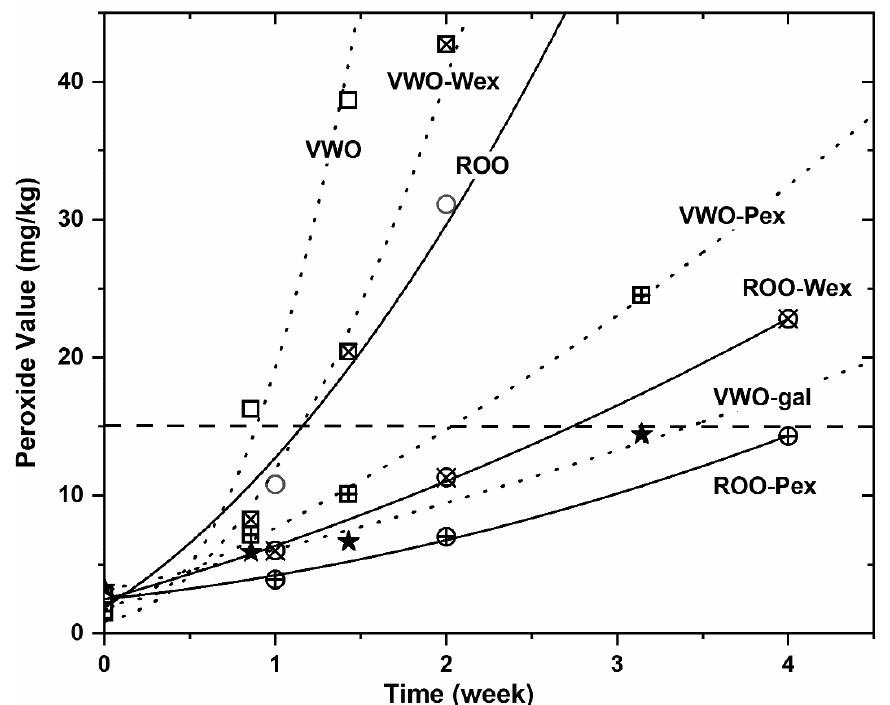
* 40 ◦ C for VWO; 60 ◦ C for VPO and ROO. VWO, virgin walnut oil; VPO, virgin pistachio oil; ROO, refined olive oil. Wex, walnut phenolic extract; Pex, pistachio phenolic extract. OSI, Rancimat (100 ◦ C, 10 L/h) induction period (h); K, initial oxidation rate constant (meq O 2 /kg/day) and PV15, time (day) required to reach a value of peroxide value (PV) equal to 15 (upper legal/commercial category limit), at 40 ◦ C (VWO) and 60 ◦ C (VPO and ROO). a–e , a different superscript letter means a statistically significant difference (at 95%) between data in columns within the same oil type (walnut, pistachio and refined).